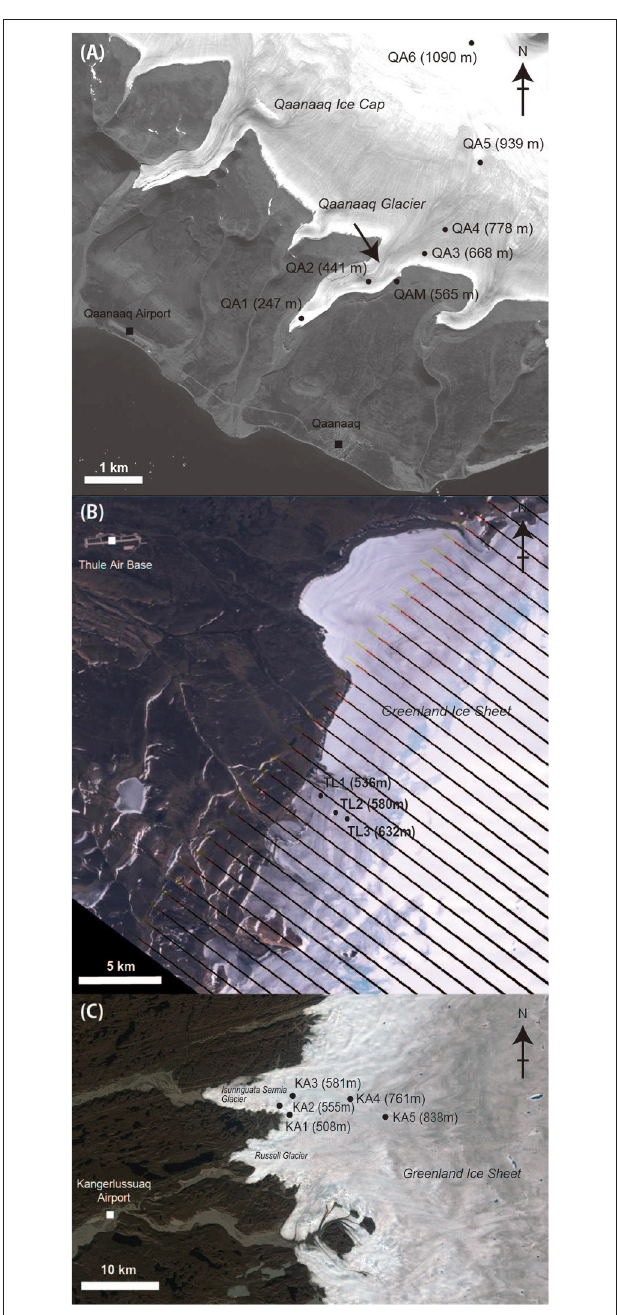
FIGURE 2 | Satellite images of (A) Qaanaaq Glacier, (B) Thule Ramp, and (C) Kangerlussuaq area showing sampling sites on the glacier surface. Images of (A) and (B) were taken in 15 July, 2012 by the Landsat-7 (ETM + ), whereas that of (C) was taken in 30 July 2012 by the QuickBird.